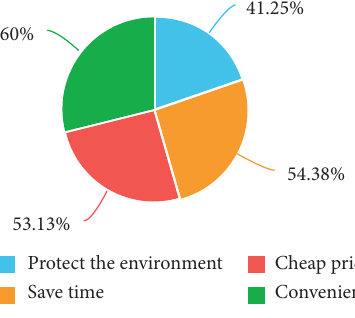
Figure 6: Reasons for using shared cars.